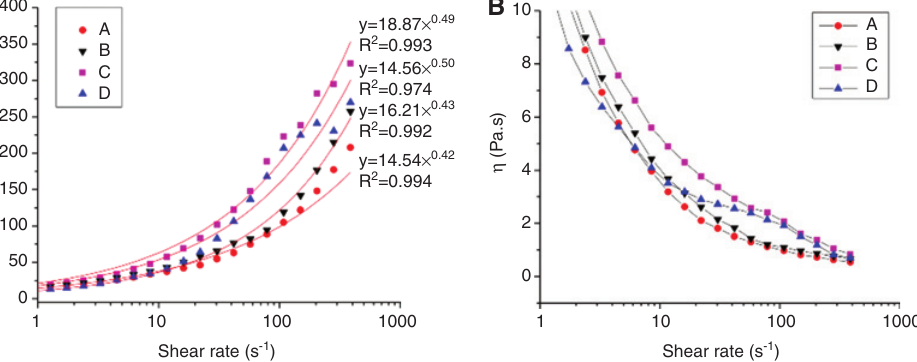
Figure 2 The rheological behavior of the feedstocks. (A) The adaptability of feedstocks with power law model, (B) viscosities of samples as a function of shear